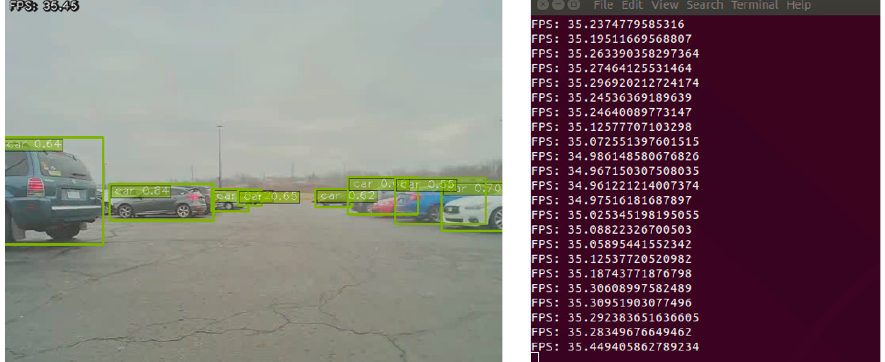
Figure 12. Example of detection results by the optimized DNN model, TL Model #4.